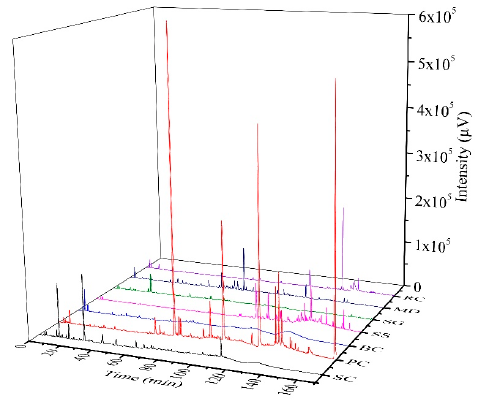
Figure 4. HPLC fingerprints of S. cuneata and its six adulterants. SC, PC, BC, SS, SG, MD, and RC were abbreviations of Sargentodoxa cuneata, Polygonum cuspidatum, Bauhinia championii,